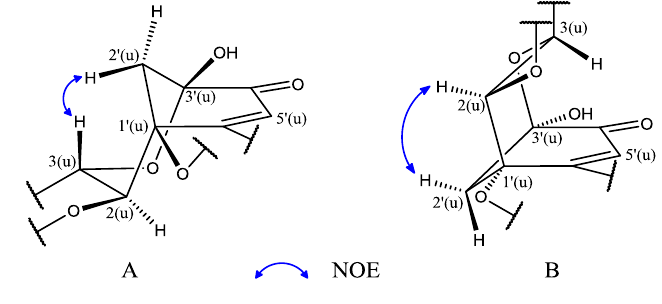
Figure 4. ( A , B ) the two conformations of compound 10 ; ( C ) Standard conformation of cyclohexenone ring showing the positive CE and its application of the octant rule; ( D ) The CD spectrum of compound 10 (1 mg/mL,